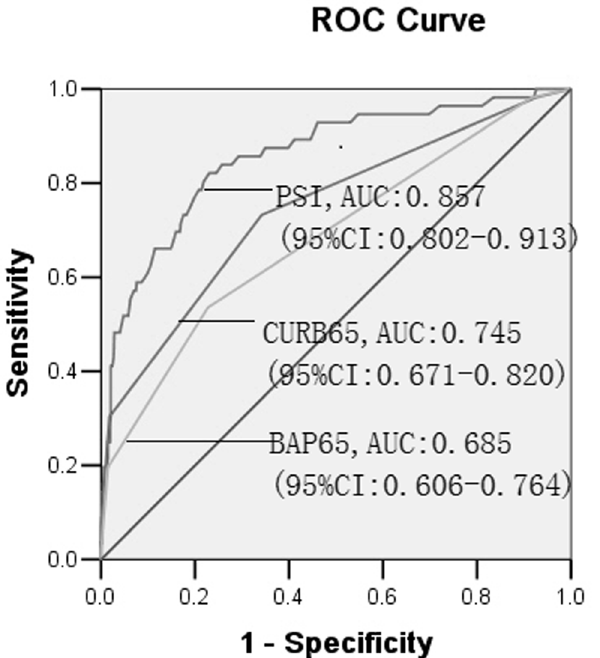
Fig 2. Receiver operating characteristic (ROC) curves for PSI, CURB65 and BAP65 score to predict in- hospital mortality in AECOPD patients with the exclusion of patients who met the criteria of IMV but who did not receive IMV according to the patients ’ wishes. AUC: area under the ROC curve; IMV: invasive mechanical ventilation.